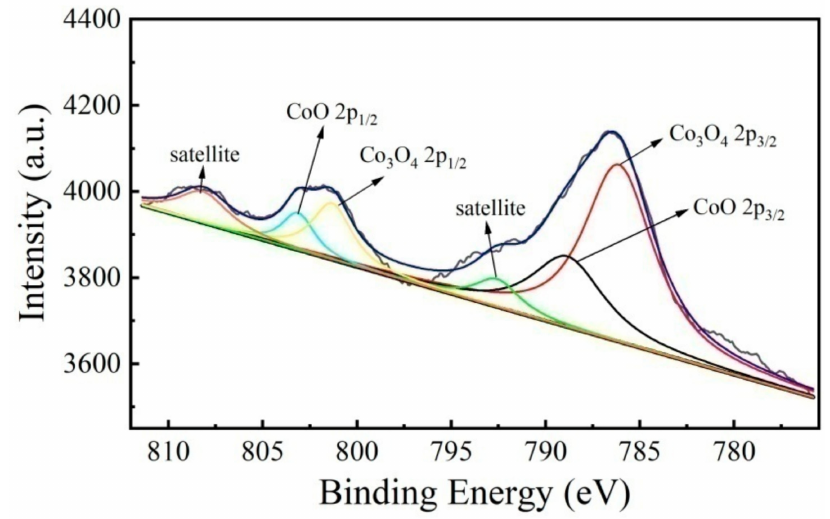
Figure 3. Co2p XPS spectra of unsupported Co/MSiO 2 material with n Co = 0.08 calcined at 400 ◦ C under N 2